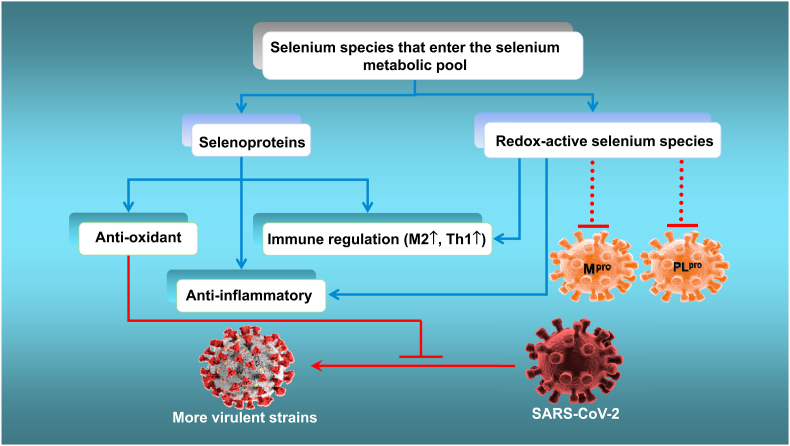
Proposed mechanism by which supranutritional levels of selenium might suppress the life cycle and mutation to virulence of SARS-COV-2 while attenuating viral-induced oxidative stress, organ damage and the cytokine storm.